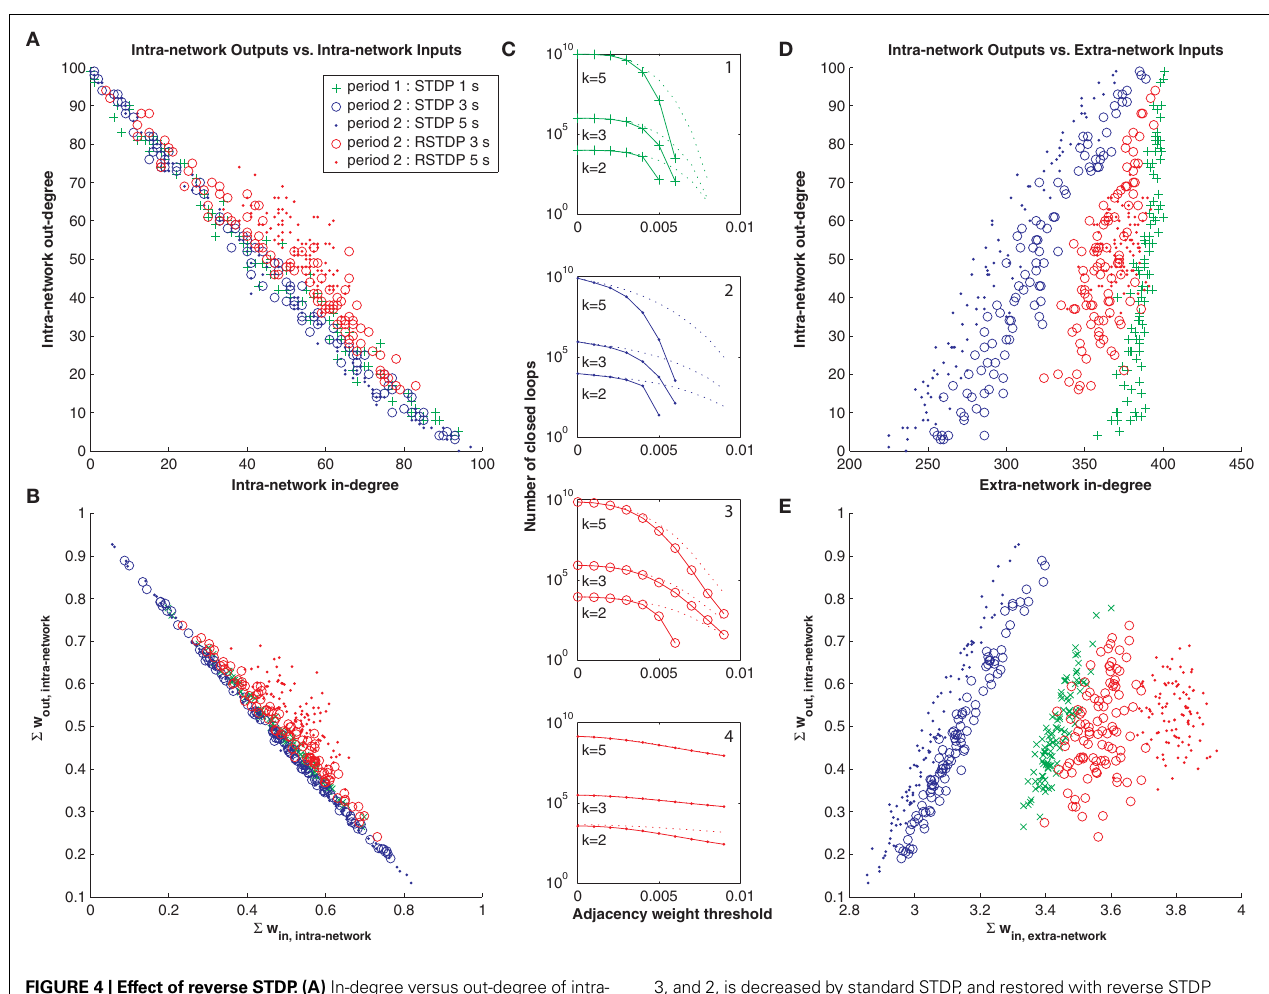
FIGURE 4 | Effect of reverse STDP. (A) In-degree versus out-degree of intra- network connections following different durations and polarities of STDP, shows a strong inverse relationship for standard STDP. Adjacency weight threshold was 0.005. Markers correspond to the network after a period of 1 second of standard STDP (green), followed by periods of 3 seconds or 5 seconds of standard STDP (blue) or reverse STDP (RSTDP, red). (B) Total synaptic input versus output for intra-network connections shows a similar inverse relationship for standard STDP. (C) Number of closed loops of length 5,